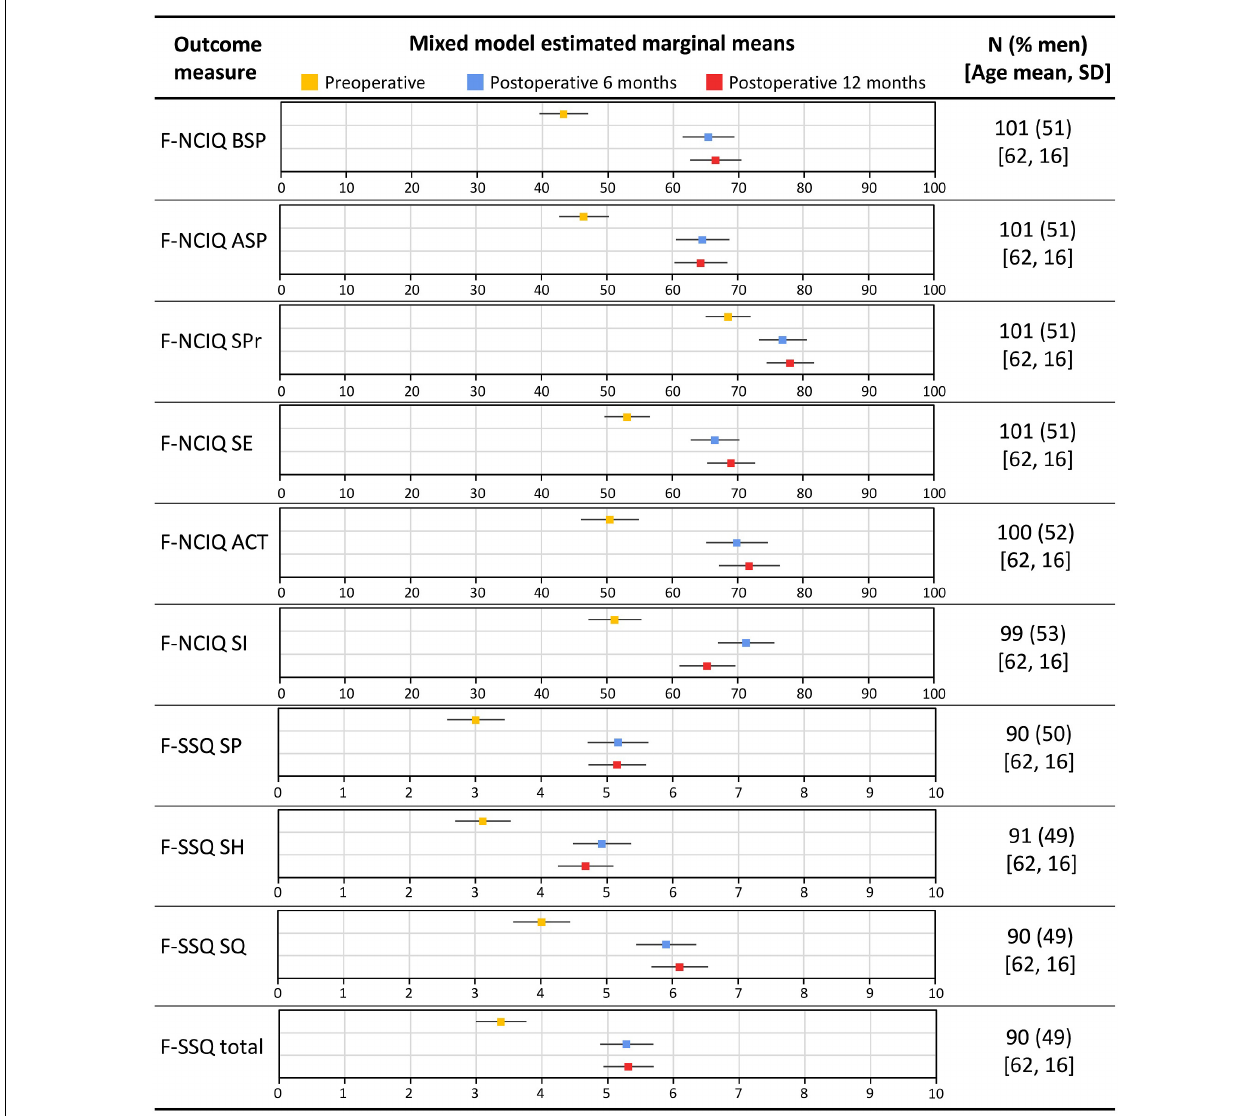
FIGURE 2 | Estimated marginal means from unadjusted mixed models for the Nijmegen Cochlear Implant Questionnaire (NCIQ) subdomain scores and the Speech, Spatial and Qualities of Hearing scale (SSQ) subdomain and total score among CI recipients. BSP, basic sound perception; ASP, advanced sound perception; SPr, speech production; SE, self-esteem; ACT, activity; SI, social interactions; SP, speech perception; SH, spatial hearing; SQ, sound quality; and SD, standard deviation. Error bars indicate 95% confidence